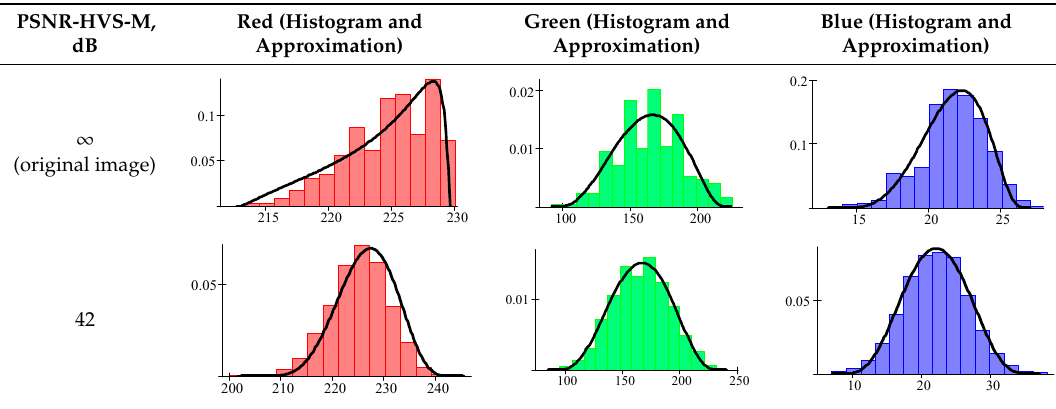
Table 3. Illustration of distribution changes due to lossy compression for Class 1.